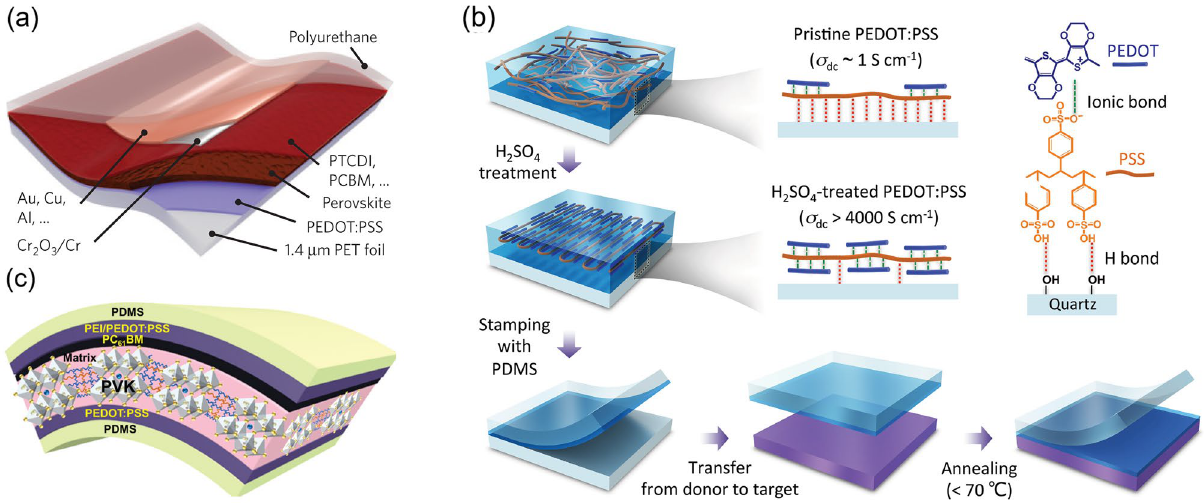
Fig. 2 a Schematic of FPSCs based on 1.4 μm PET/PEDOT:PSS substrate. Reproduced with permission from Ref. [7]. Copyright 2015, Springer Nature. b Illustration of the acid-assisted transfer-printing strategy. Reproduced with permission from Ref. [72]. Copyright 2015, John Wiley and Sons. c Schematic of FPSCs with PEDOT:PSS as both cathode and anode. Reproduced with permission from Ref. [19]. Copyright 2019, Royal Society of